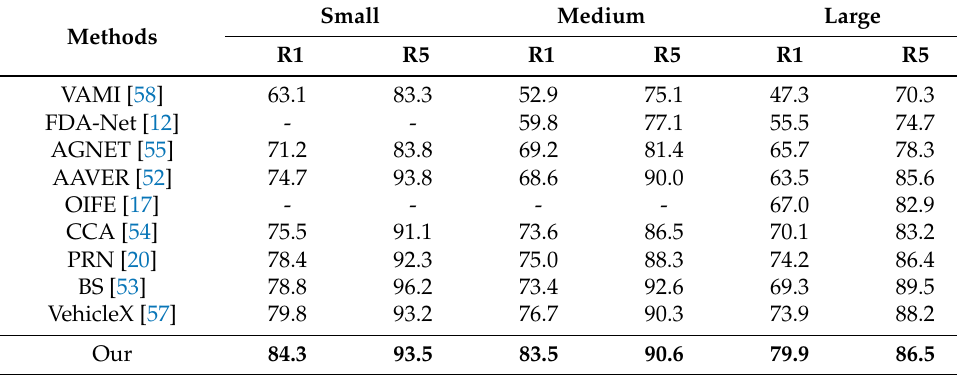
Table 4. Comparison of the Sota on VehicleID (%).